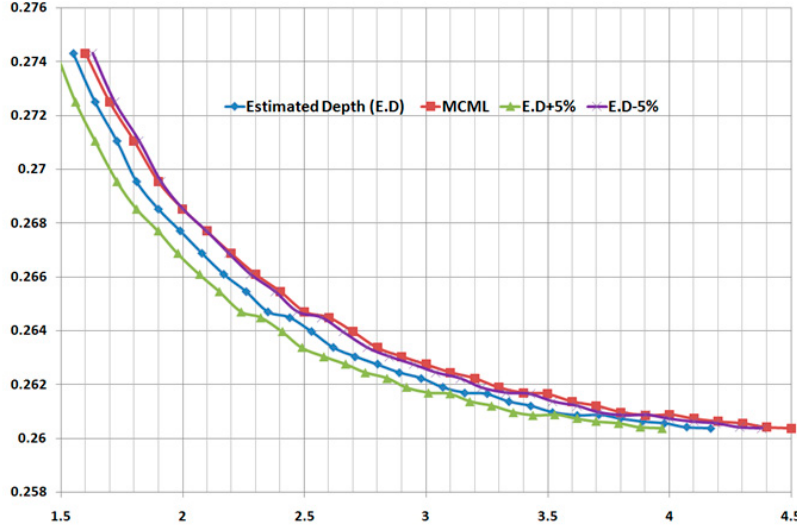
Figure 3. Vein’s depth calculated (E.D) from the mathematical model against the diffused reflectance computed MCML simulations with vessels depth varied from 1.6 to 4.5 mm. Horizontal axes shows vessels depth in mm and vertical axes shows the measured diffused reflectance Rd through simulation.